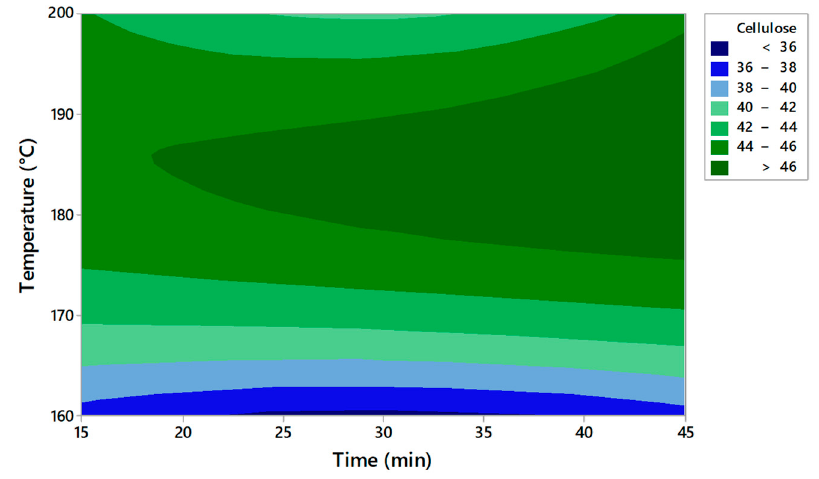
Figure 2. Contour plots of cellulose content depending on time and temperature.